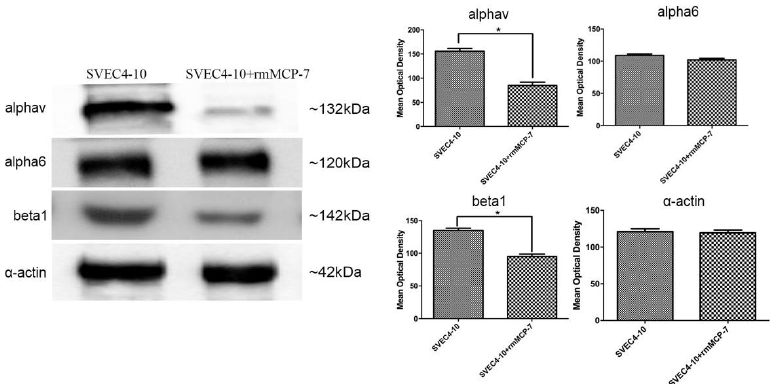
Figure 3. rmMCP-7 decreases the levels of α v and β 1 integrin subunits during angiogenesis in vitro. α 6 subunit levels remain unchanged. Integrin levels were analyzed by Western blot after tube formation assay. The graphs show the quantification of Western blot bands by densitometry. α -actin was used as a loading control. Data from three independent experiments. * p <